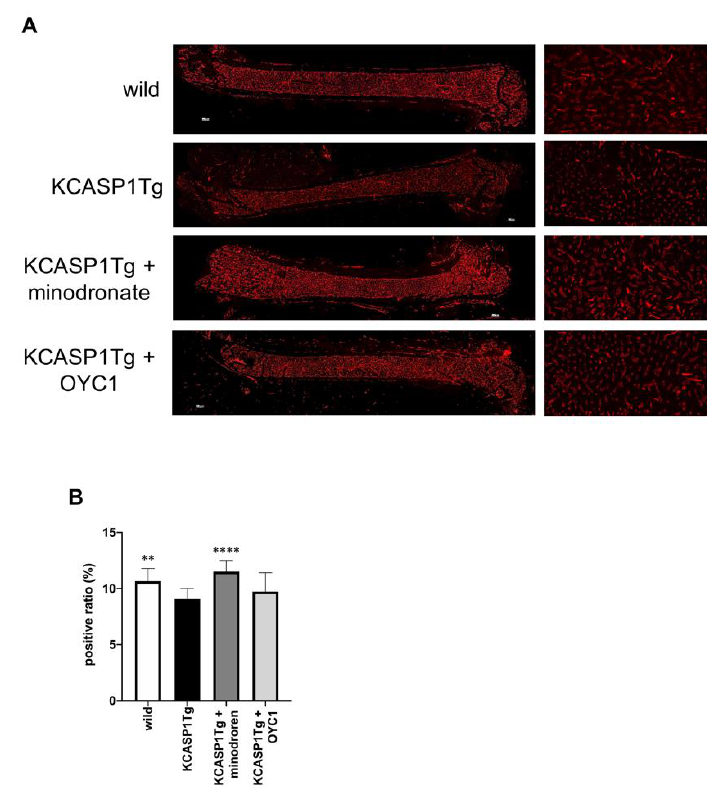
Figure 6. Blood flow evaluation in the femur by MECA-32 staining. In order to evaluate the blood flow in the femur, we performed fluorescent immunostaining with MECA-32, a vascular endothelial cell marker. In KCASP1Tg mice, the diameter of the blood vessels in the bone marrow was decreased (left panel scale bar is 300 µm, right panel × 100, ( A )). We calculated the blood vessel area per bone marrow area (positive ratio) in three randomly selected locations (×100, n = 3 per group). The ratio was decreased in KCASP1Tg mice compared to wild-type littermates, while minodronate significantly improved the vascular area ( B ). **; p < 0.01, ****; p < 0.0001 compared to KCASP1Tg mice by Mann – Whitney